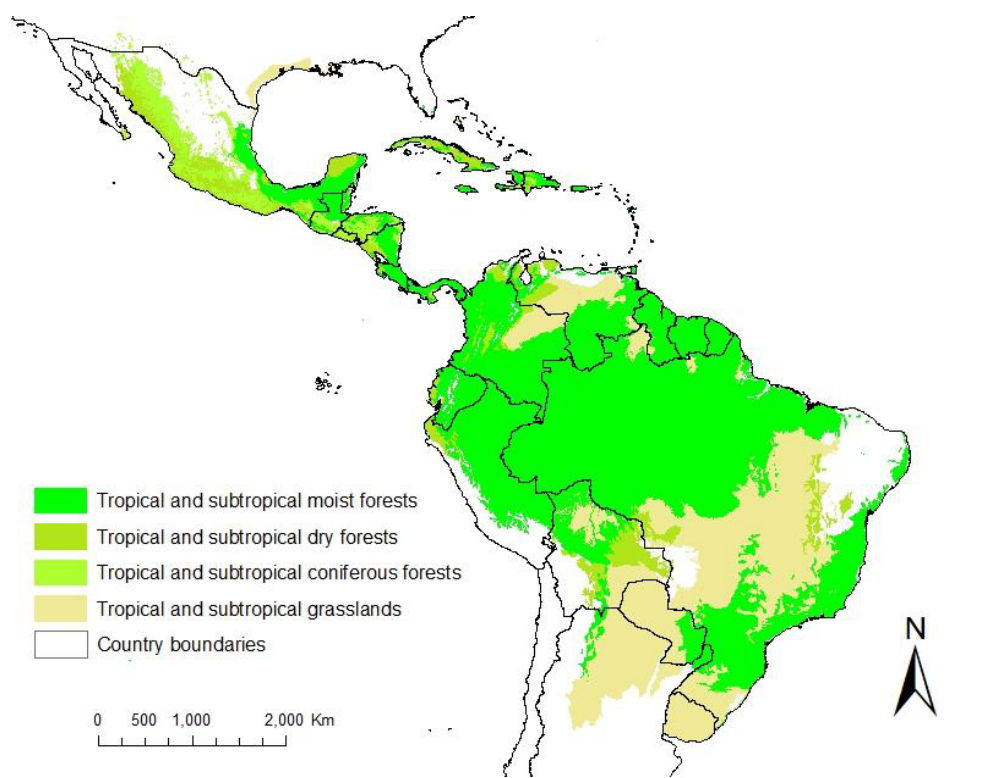
Authors’ mapping of data from WWF